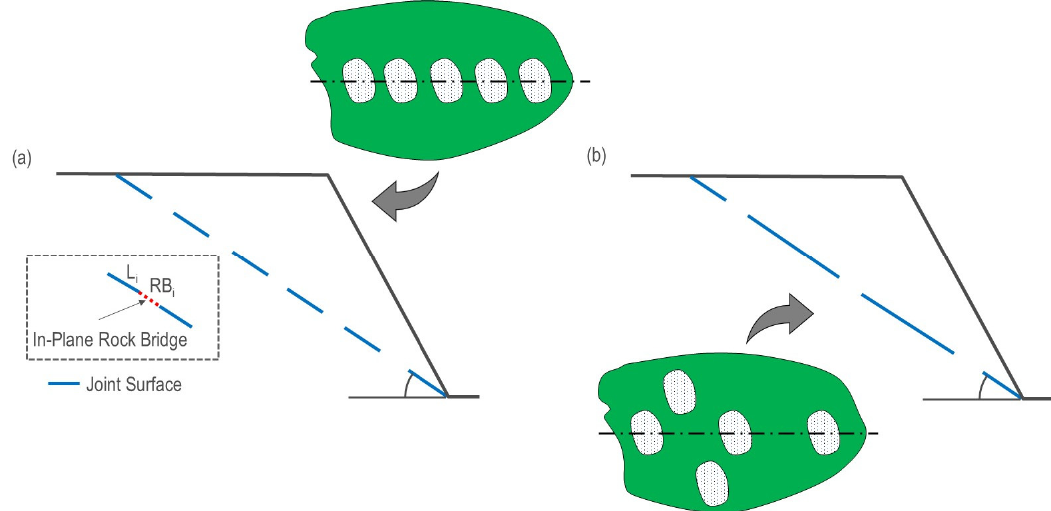
Figure 4. Simple slope problem describing the challenges of representing in-plane rock bridges using the method proposed by [3,5,6]. Even though ( a , b ) represent equivalent in-plane rock bridge conditions, a 2D cross section would result in different rock bridge lengths between ( a , b ).